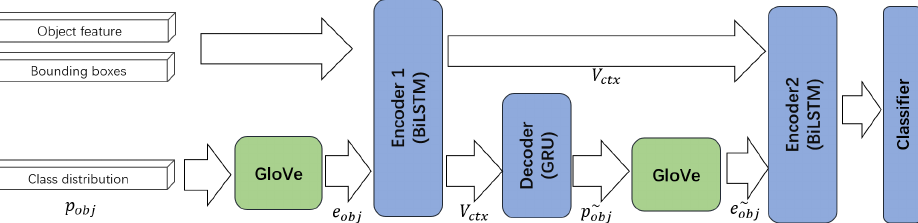
Figure 4. Structure of the relational reasoning module. GloVe word vectors are used to